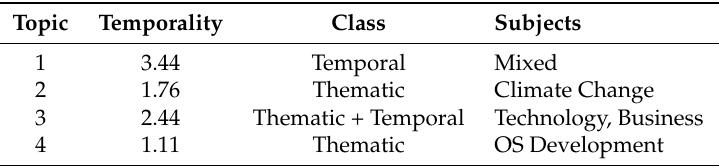
Table 4. Qualitative assessment of topics in Figure